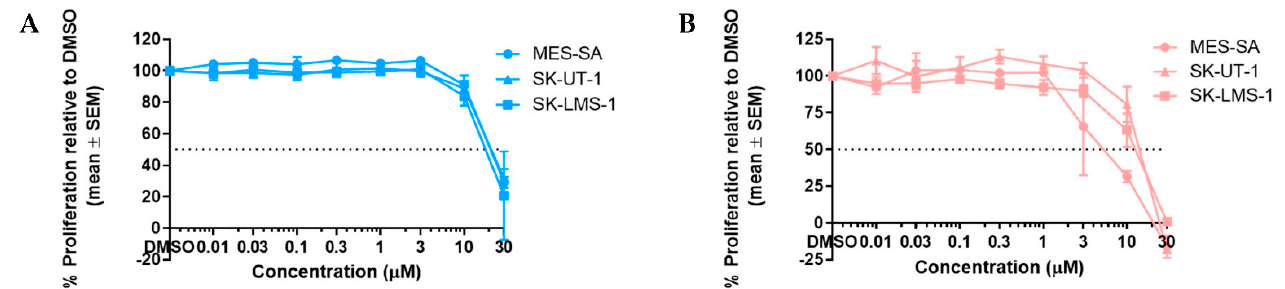
Figure 9. Growth inhibition curves for MES-SA, SK-UT-1 and SK-LMS-1 following incubation for 72 h with ( A ) Venetoclax; ( B ) MIM1 as determined by SRB. Data points represent mean ± SEM of three independent repeats.